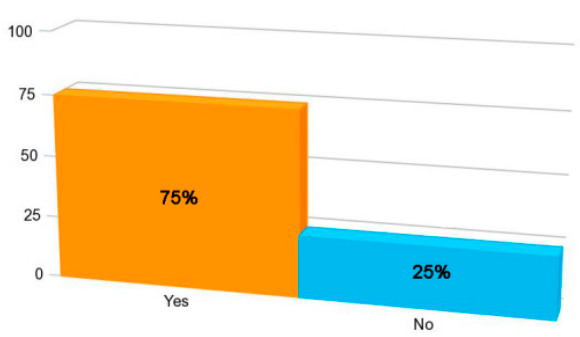
Figure 6. The % of GPs with program to reduce energy consumption and supply from RES.